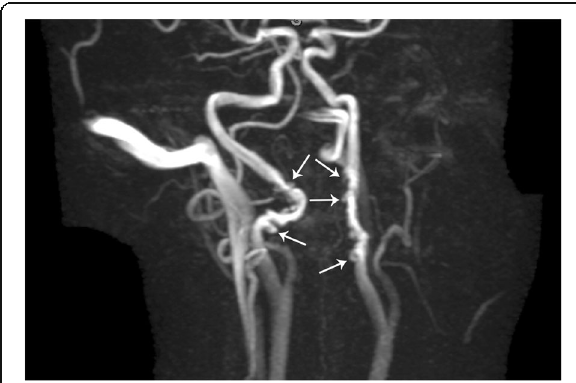
Fig. 16 Fibromuscular dysplasia. MR angiography image of the bilateral internal carotid arteries demonstrates a "string-of-beads" appearance (arrows)